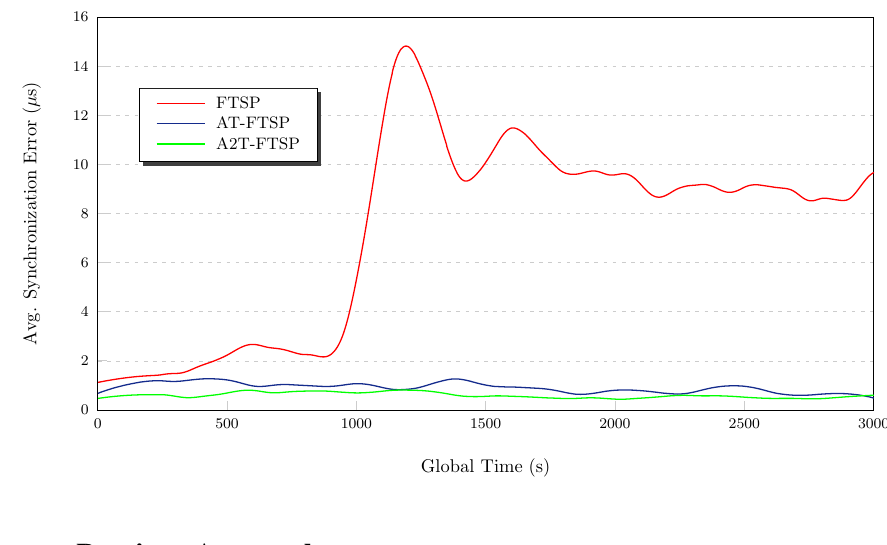
Figure 8. Behavior study: 22 ◦ C– 40 ◦